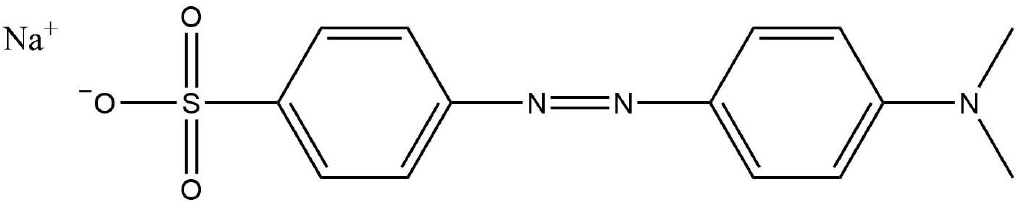
Figure 2. Chemical structure of methyl orange.